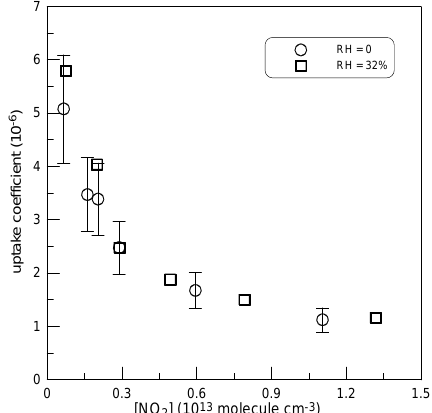
Fig. 5. Dependence of the initial rate of NO 2 loss on the mass of TiO 2 sample (per 1cm length of the support tube): P = 1Torr, ∼= 0.006s − 1 , [NO ∼ 10 12 moleculecm − 3 . T = 300K, J NO 2 ] 2